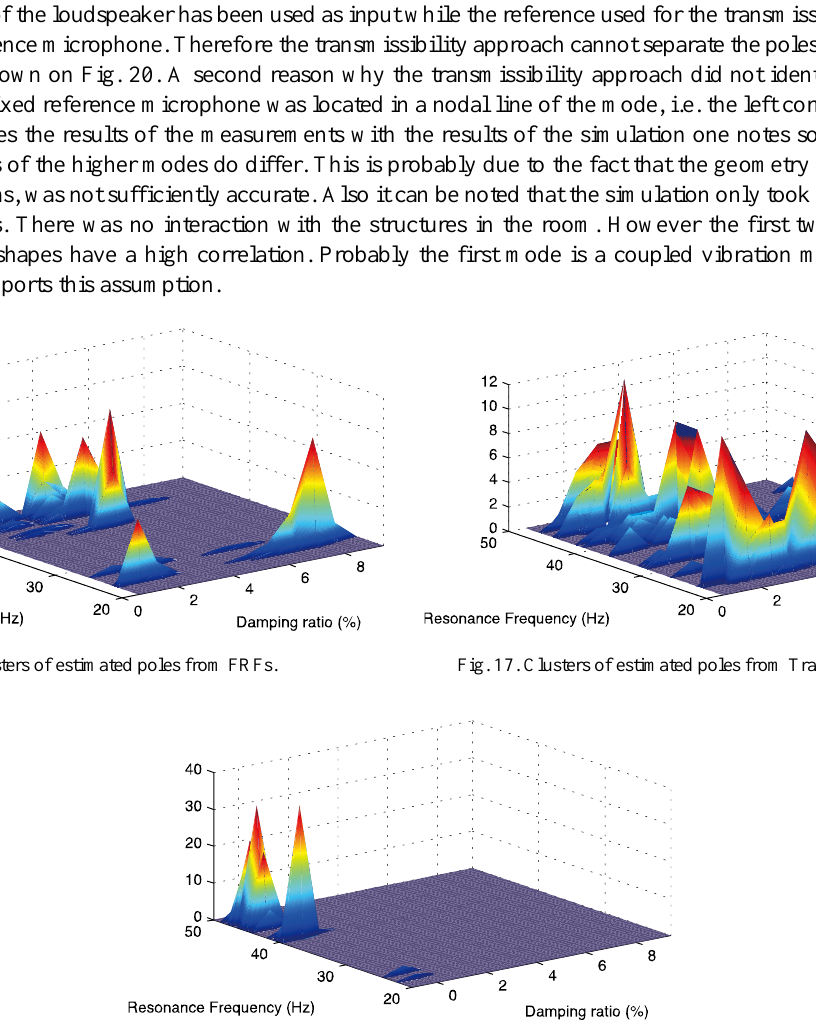
Fig. 18. Clusters of estimated poles from